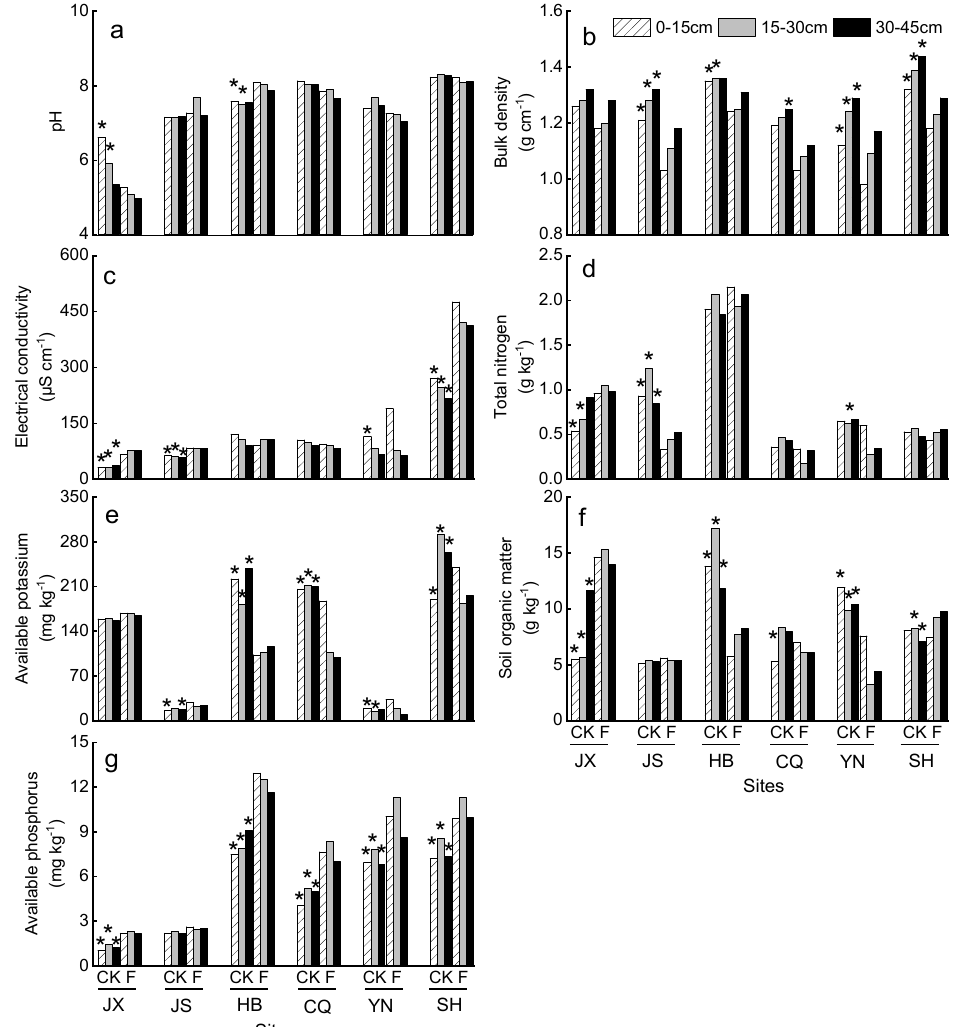
Figure 2. Soil properties in different T . Zhongshanshan plantations with increased age. Lowercase letters in the upper left corner represent pH ( a ), bulk density ( b ), electrical conductivity ( c ), total nitrogen ( d ), available potassium ( e ), soil organic matter ( f ), available phosphorus ( g ), respectively. The asterisks on the column indicate significant differences ( p < 0.05) between CK and F of the same layer in each site. JX = Jiangxi; JS = Jiangsu; HB = Hubei; CQ = Chongqing; YN = Yunnan; SH = Shanghai; CK = non-forested soils; F = forested